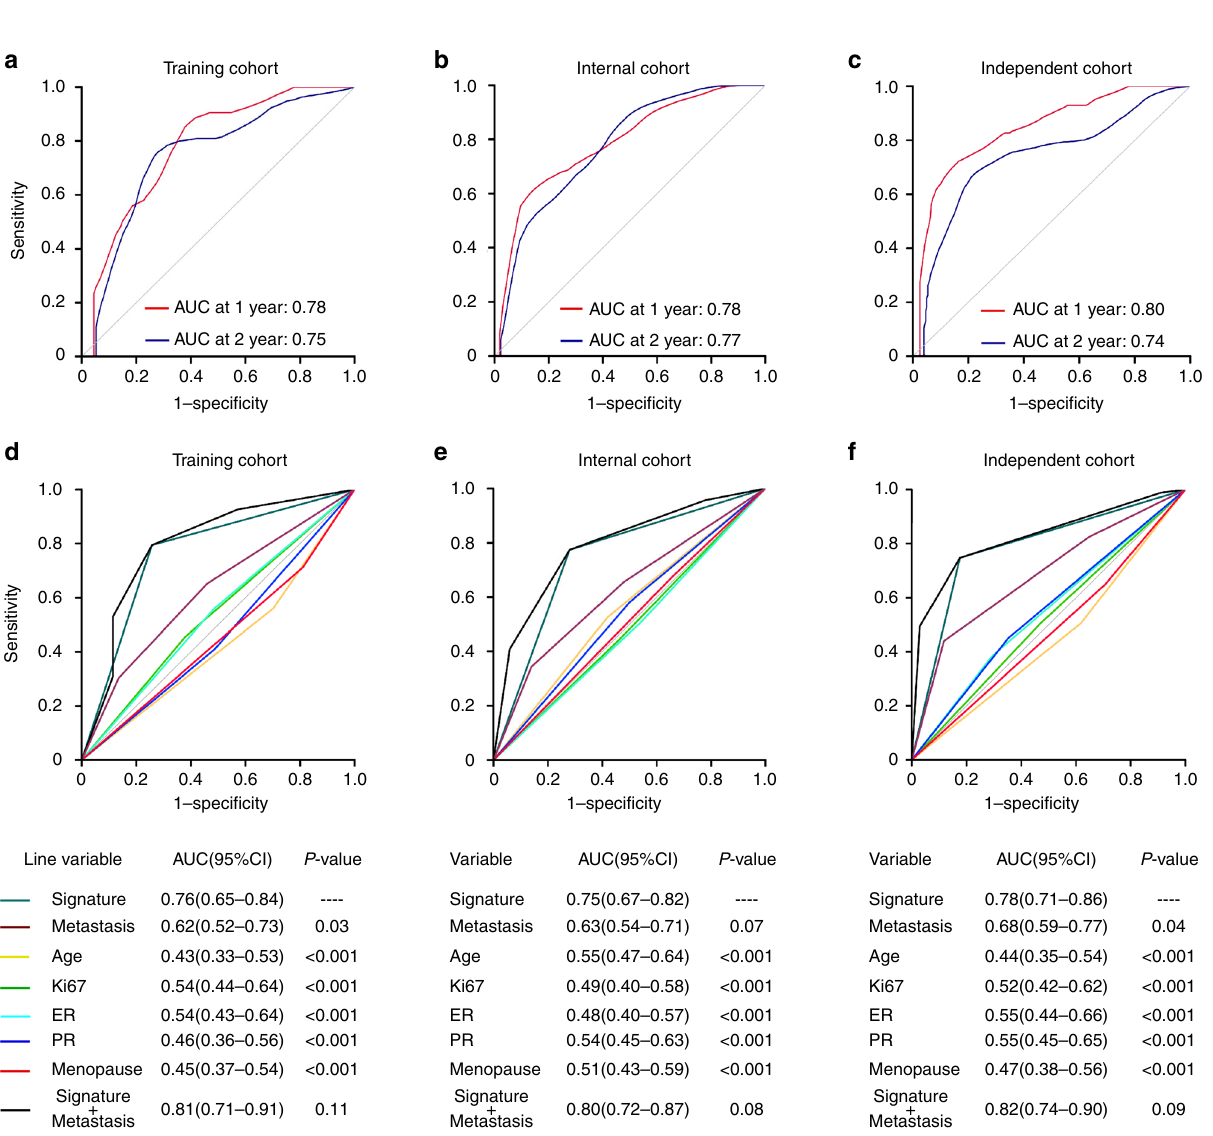
(Fig. 5 and Supplementary Table. 4). The P -values for interaction analysis between trastuzumab treatment status and the risk score was signi fi cant in OS and PFS ( P (trastuzumab×high-risk score) < 0.001,